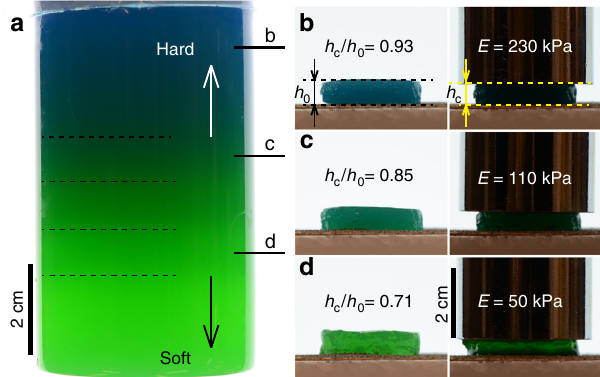
Fig. 4 Single-step fabrication of soft layered gels. a Horizontal layers (in different colors) are created from an agarose solution in a single-step process by injecting 100 ml 4 wt% agarose solution with 0.0015 wt% methylene blue hydrate into 100 ml 9.1 wt% NaCl solution containing 0.002 wt% fl uorescein sodium salt. Boundaries of the layers are marked with dashed lines. The layers differ from one another in softness due to the different concentrations of agarose, i.e. the bottom layers are softer than those at the top. b – d Cylindrical gel slabs, which are cut from different layers in the gel, show different mechanical properties. Therefore, applying the same vertical load on the slabs results in different degrees of compression and thus indicates the different Young ’ s moduli of the gel in these horizontal